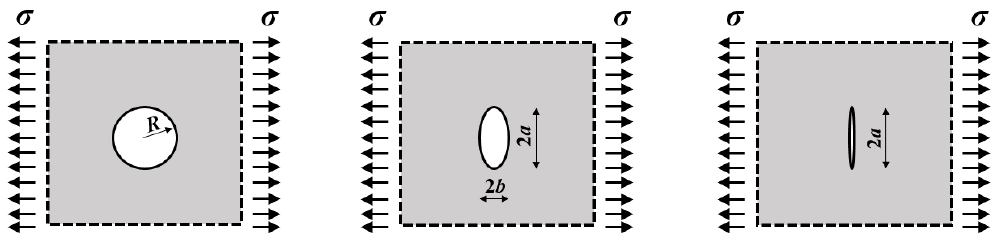
Figure 2. Transition from stress concentration (circular and elliptical hole) to stress intensification